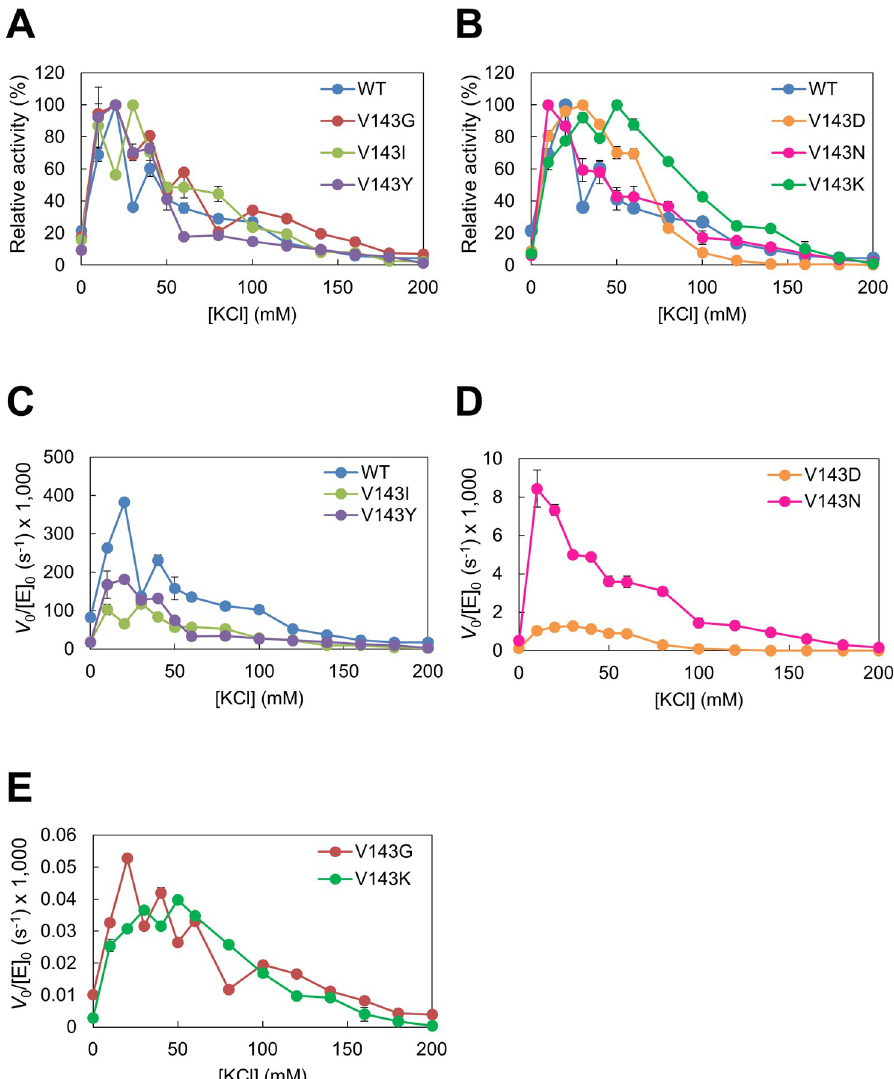
Fig 6. Dependence of activity of Val143 variants on KCl concentration for R18/D18. The reaction was carried out with 5.6 nM R18/D18 in 50 mM Tris-HCl buffer (pH 8.0), 5 mM MgCl 2 , 0–200 mM KCl at 25˚C. Relative activity (A, B), which was defined as the ratio of the activity to the highest activity, and the initial reaction rates per enzyme concentration (C–E) against KCl concentration are shown. Error bars indicate SD values of triplicate determination. The original data are in S3